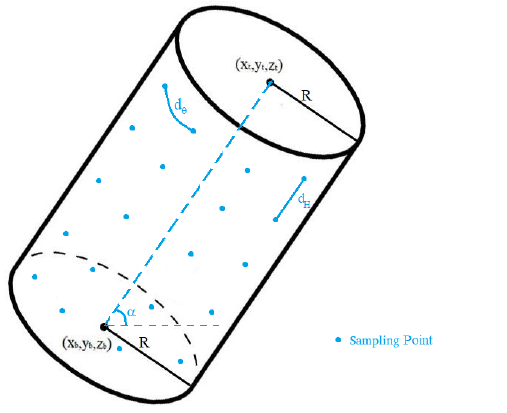
Figure 4. Cylinder parameters and sampling